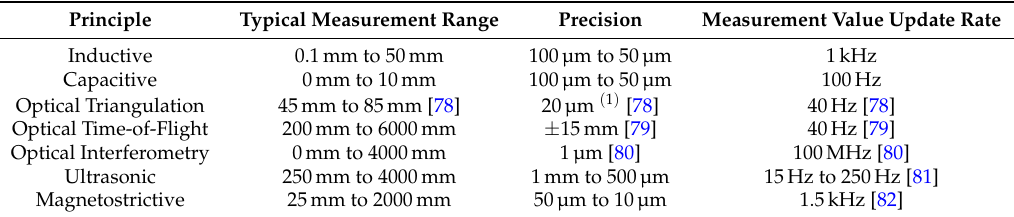
Table 1. Typical values for commercially available sensors for distance measurements and ranging according to [77] if not stated otherwise.